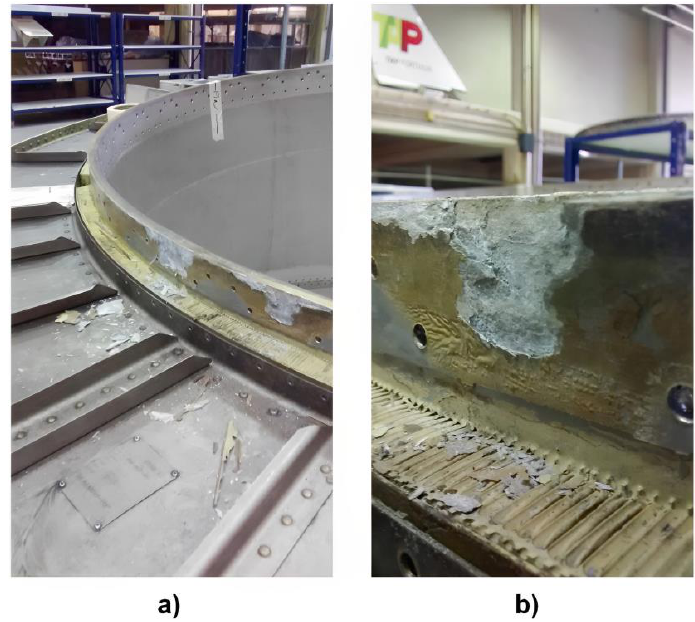
Figure 4. A320 intake ( a ) corrosion pattern, ( b ) aluminum corrosion detail.